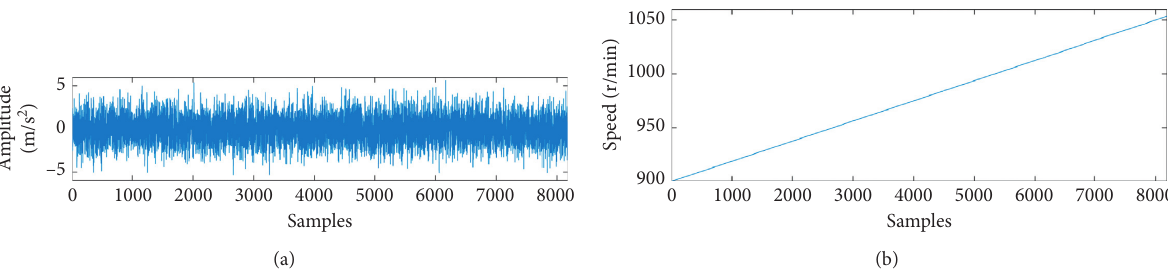
Figure 3: Simulated signal of bearing fault with noise. (a) The waveform of vibration and (b) speed trend.